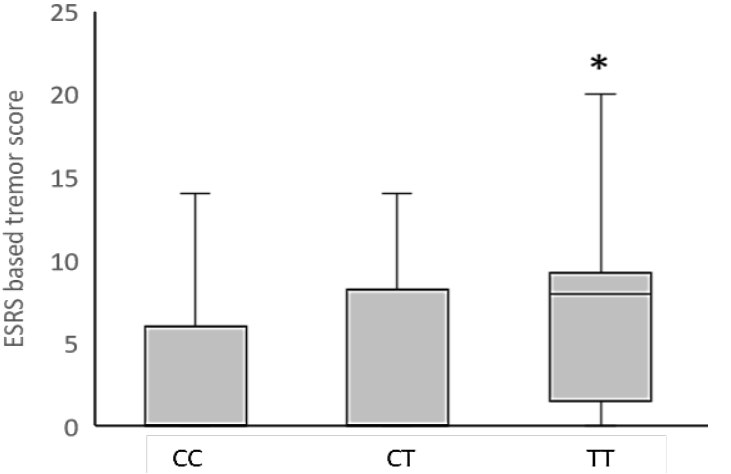
Figure 1. Distribution of ESRS-based tremor/hyperkinesia scores in haloperidol-treated schizophre- nia patients with different HTR6 rs1805054 genotypes. Data are expressed as median (Q1; Q3). * p = 0.011 vs. CC genotype carriers, Dunn’s post-hoc test following Kruskal–Wallis